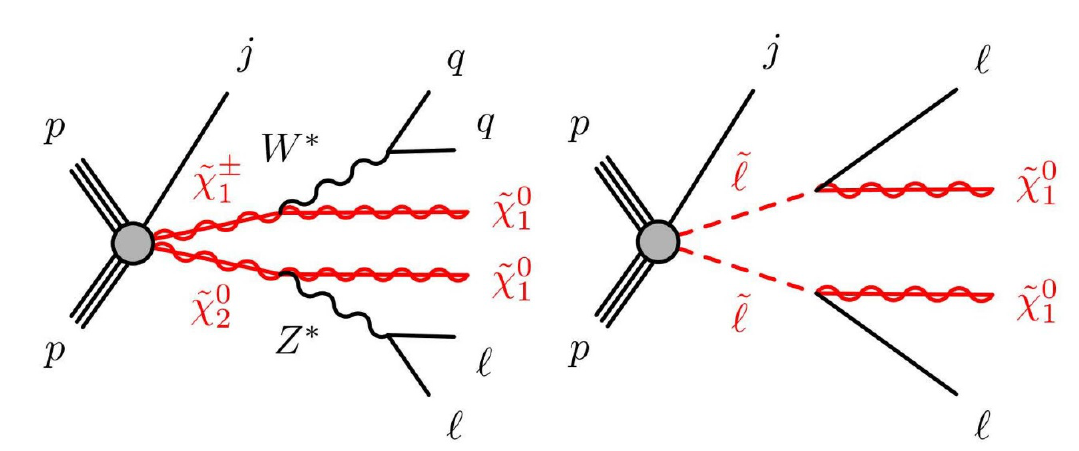
~ (cid:31) (cid:6) in the BWL 2 1